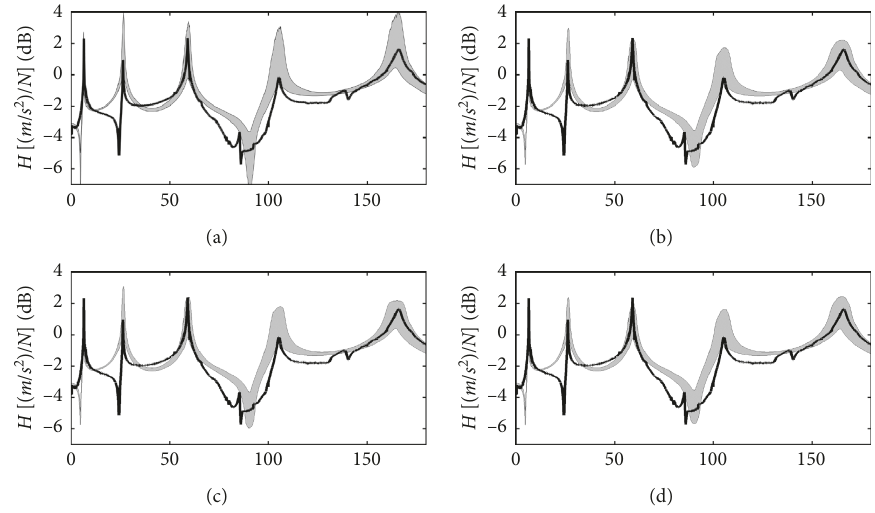
Figure 12: FRFs for scenario A4 and prior covariance matrix with λ credibility interval provided by model predictions. (a) Freq. (Hz) DH1. (b) Freq. (Hz) DH2. (c) Freq. (Hz) DH3. (d) Freq. (Hz)